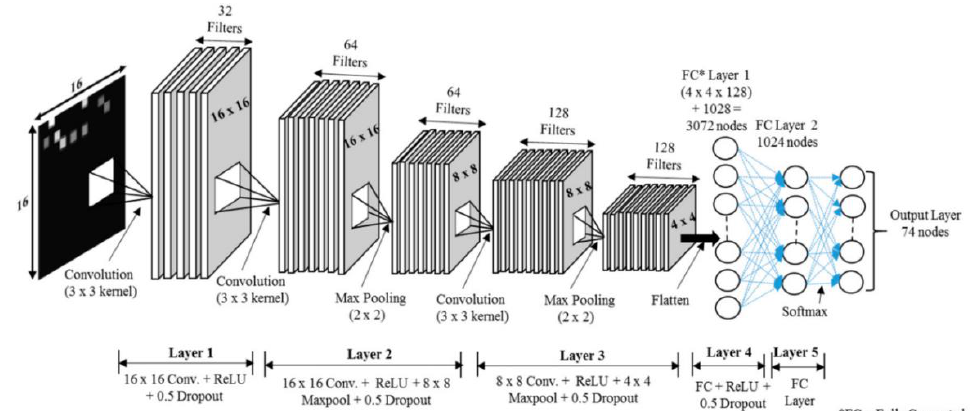
Figure 5. The convolutional neural network (CNN) architecture used in this study [14]. The second layer had a total of 18,496 parameters and the FC layer had 3072 counters, which led to the next hidden FC layer with 1024 converters. Finally, a softmax layer with 74 routines was used.